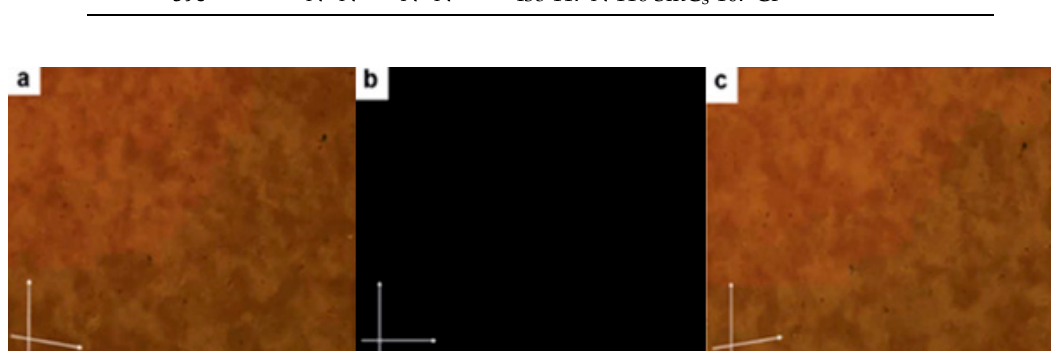
Figure 9. Textures of the DC phase obtained for compound 39a at T = 50 °C ( a , c ) between the uncrossed